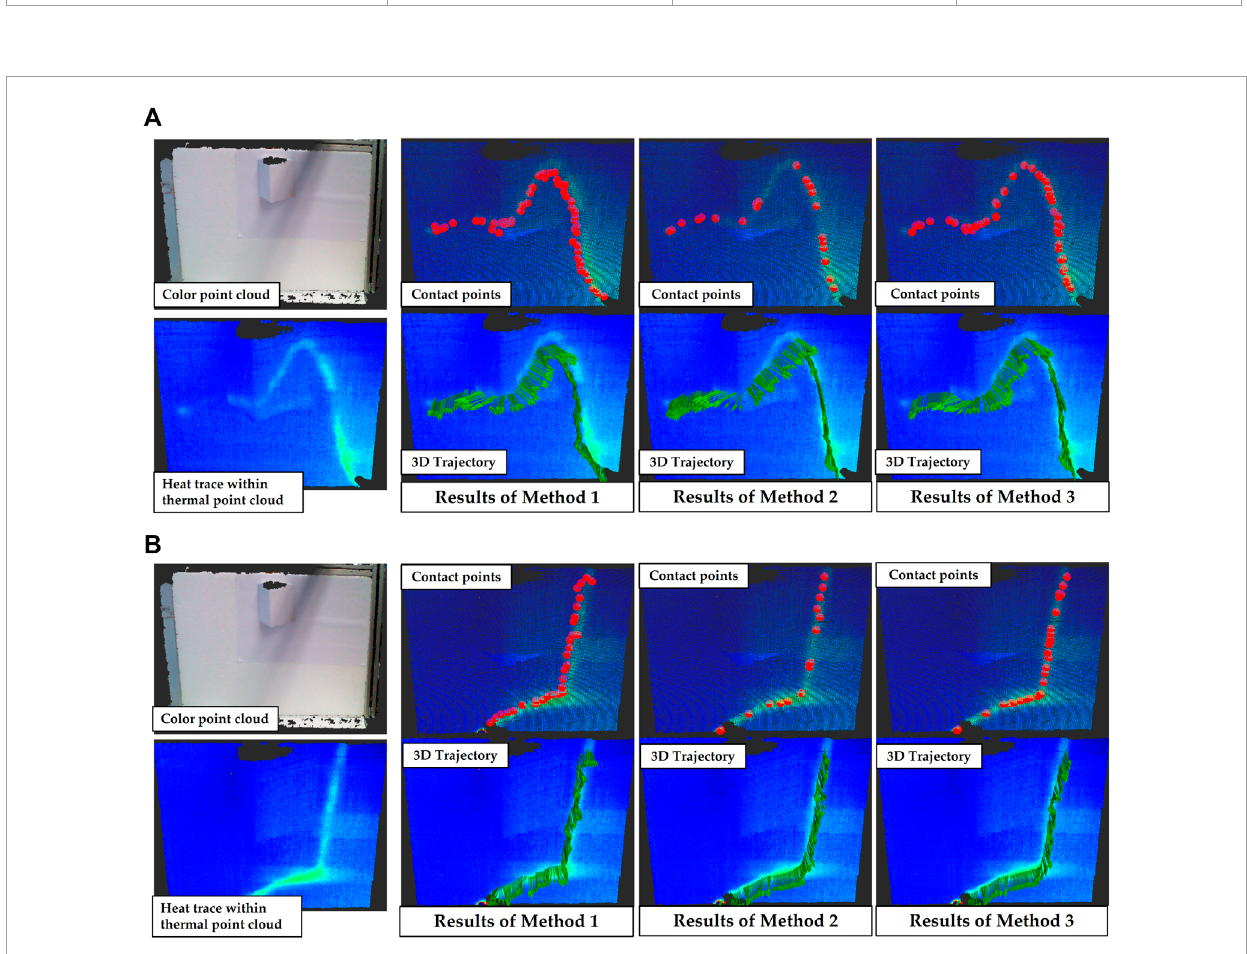
FIGURE 10 Robot motion trajectory predictions for two arbitrary finger movements are shown in figures (A,B) . In each subfigure, the first column shows a color object point cloud (top) and a residual heat trace presented within a thermal point cloud (bottom); the following columns show the predicted contact points (top) and interpolated 3D trajectories (bottom) obtained using various three methods. (left to right: Method 1: anchor points were defined directly as contact points. This means that this method is not based on temperature analysis. Method 2: contact points were estimated using likelihoods that were positively correlated with temperature in the neighborhoods of the anchor points. In other words, in this method the temperature is analyzed as a static feature similar to color. In method 3, likelihoods negatively dependent on the divergence were used for prediction (our